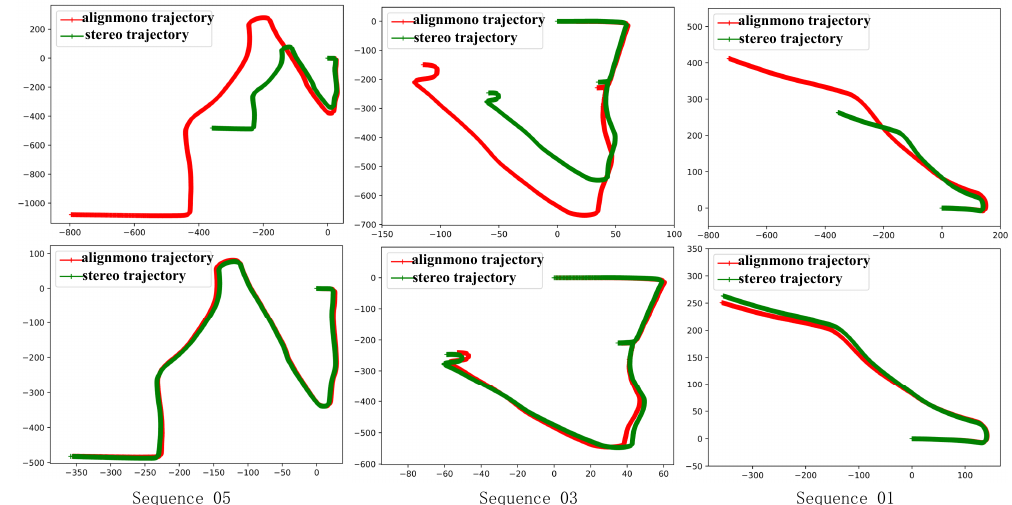
Figure 8. The top pictures show the results of Nist’s method with constant scale. By contrast, the bottom pictures shows our method with a better validity and